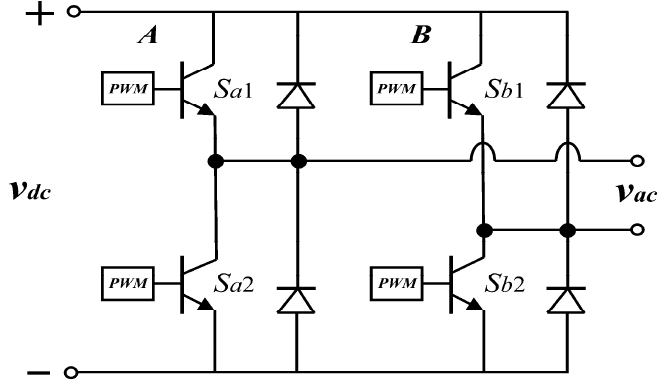
Figure 3. Single-phase full-bridge inverter.